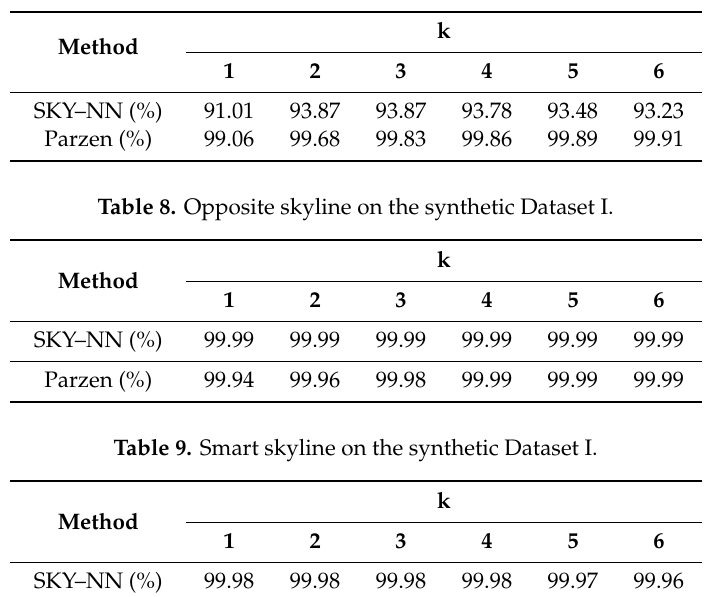
Table 7. Double skyline on the synthetic Dataset I.